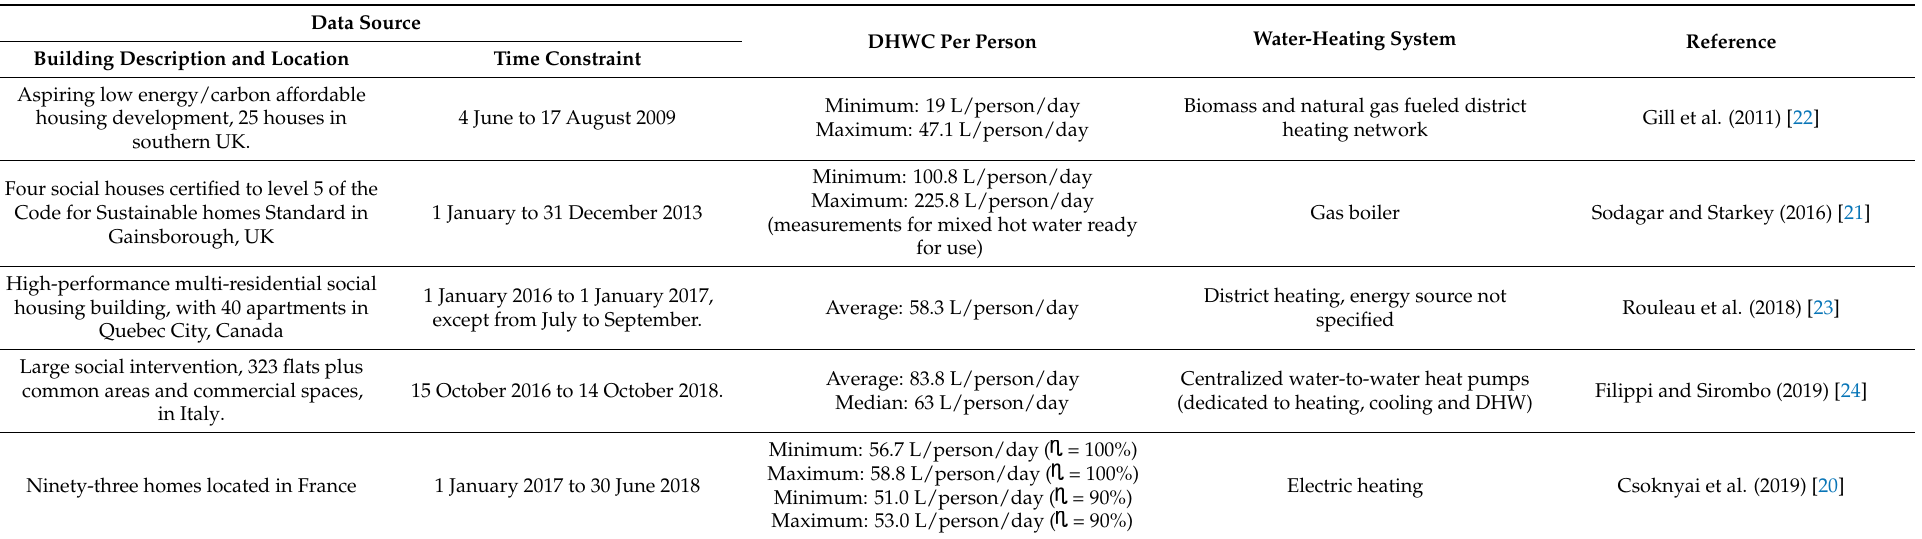
Table 2. DHWC per person from monitoring studies in social